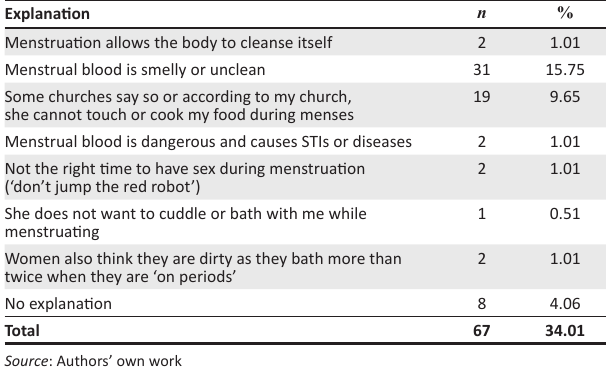
TABLE 1: Family planning-related explanations. TABLE 2: Menstruation-related explanations.